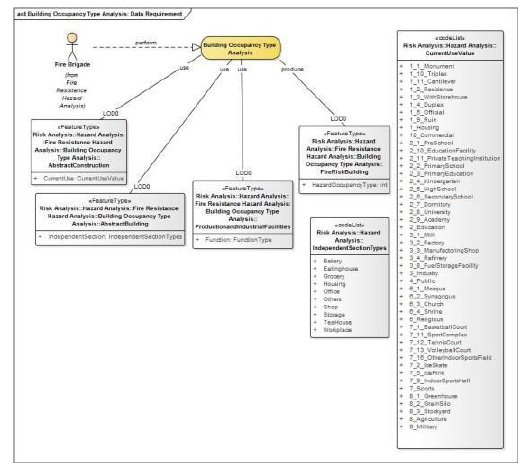
Figure 7: Geo-information requirements diagram of “building